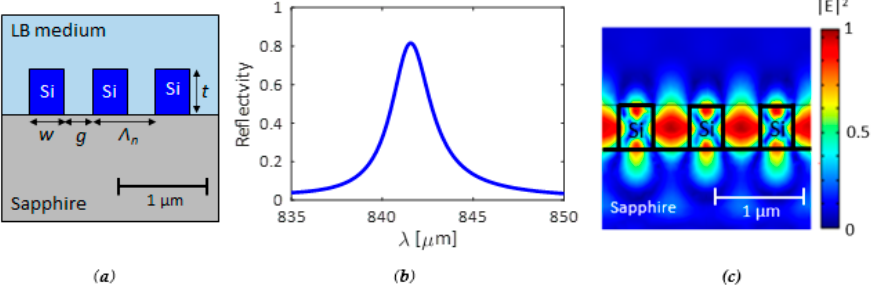
Figure 2. ( a ) Configuration of the GMR structure ( LB : Lysogeny Broth); ( b ) Reflection spectrum; ( c ) Energy confinement at the resonance wavelength λ ≈ 841.5 nm.